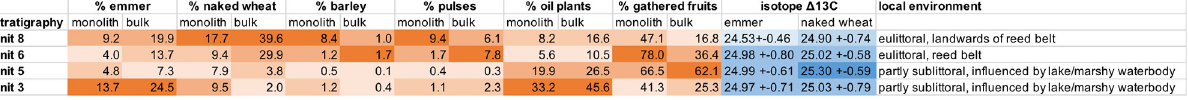
Fig 21. Summary of the different measured indicators of units 3, 5, 6 and 8 of Zug-Riedmatt. Percentages of caloric input, isotope values and local environmental conditions (based on [8]).